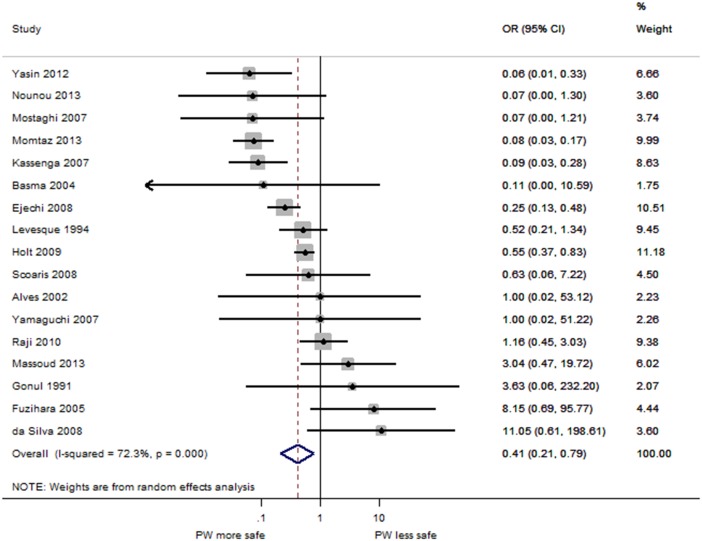
Forest plot of PW and tap water sources.Forest plot of the odds ratio of fecal contamination comparing PW and tap water sources.